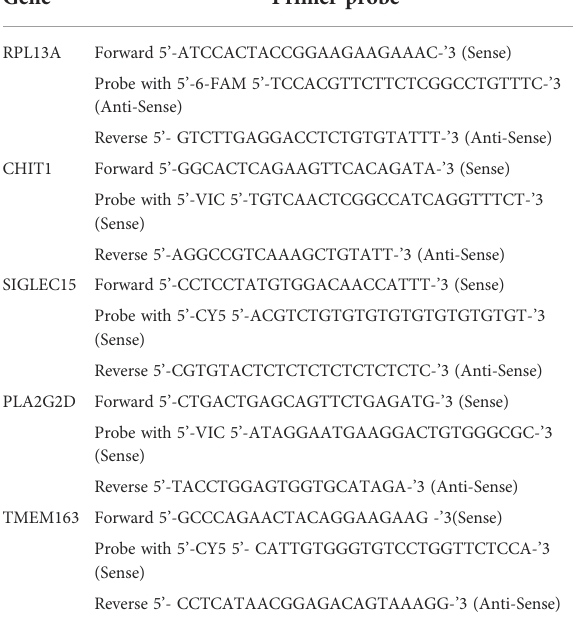
TABLE 2 Primer sequences of RPL13A, CHIT1, SIGLEC15, PLA2G2D and TMEM163. Gene Primer-probe